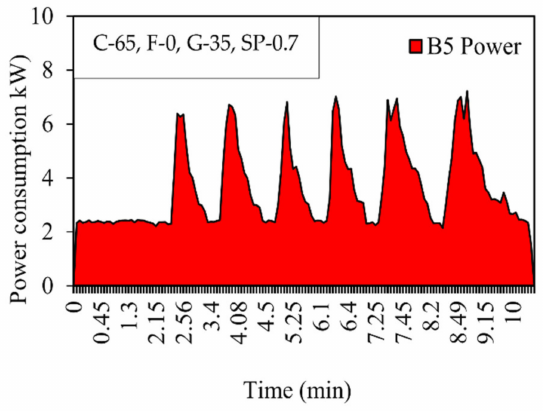
Figure 6. Energy consumption curve for M30 grade concrete for Mix B1, B2, B3, B4, and B5. C— Cement, F—Fly ash, G—GGBS, SP—Superplasticizer (expressed in %).